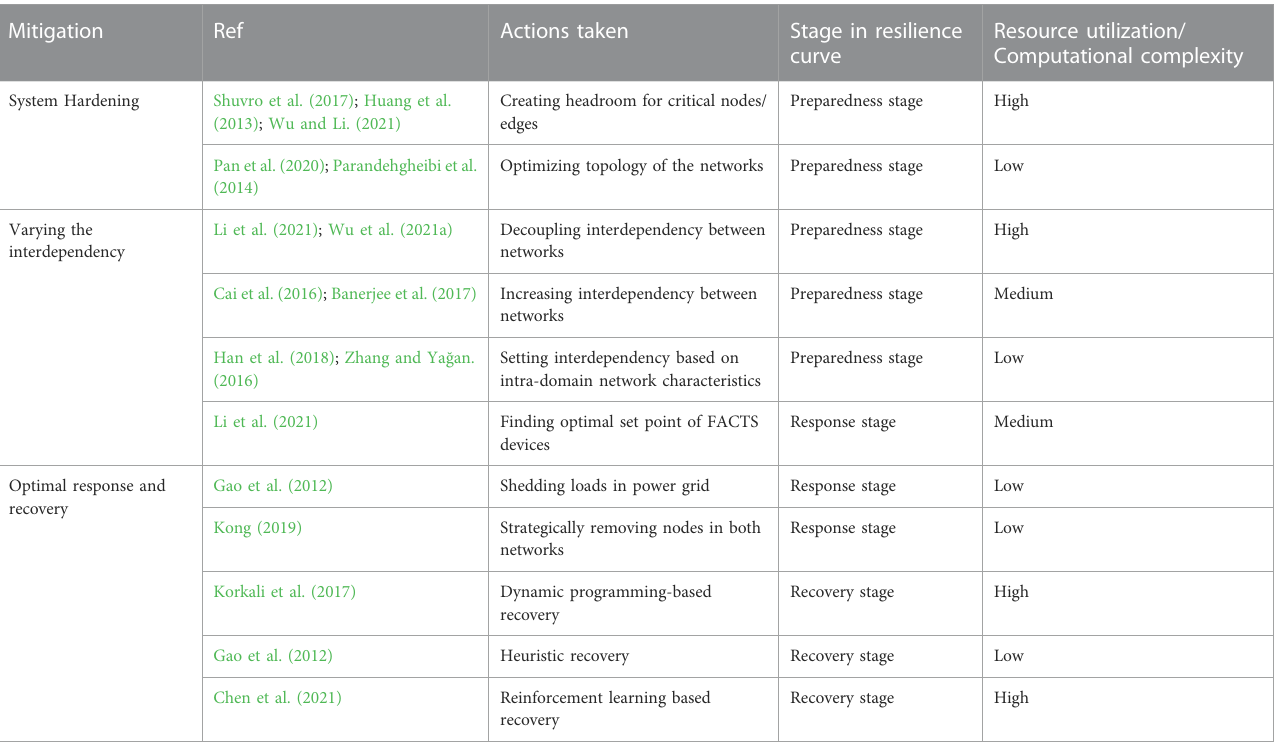
TABLE 3 Summary of mitigation cascading failure strategies in CPPS.